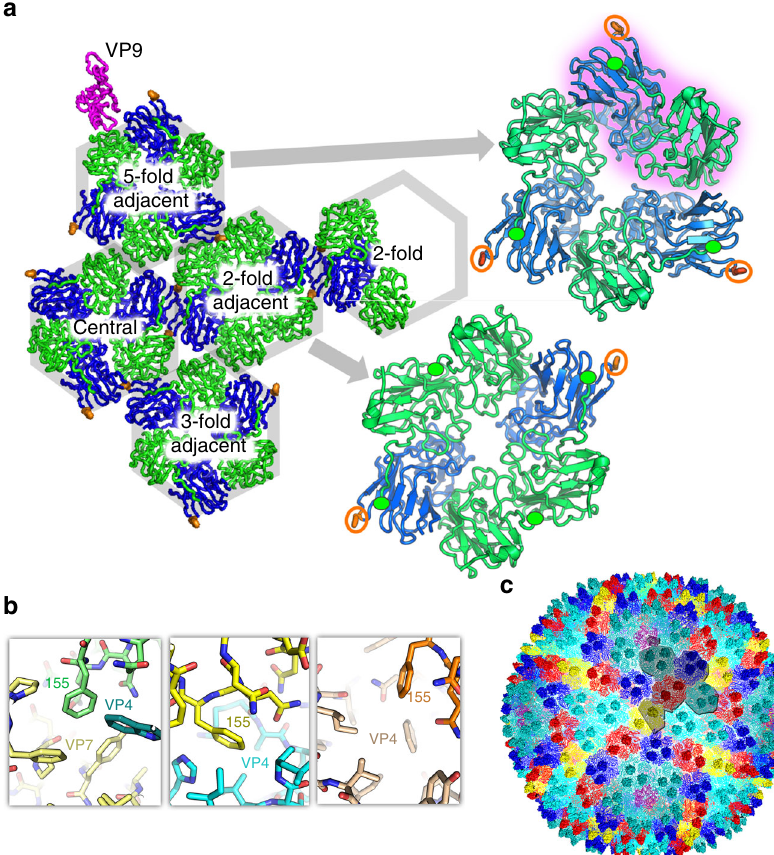
Fig. 2 Hetero-hexamer building blocks. a An icosahedral asymmetric unit, viewed from the inside. VP4 is blue, VP7 green and VP9 magenta. The hexamers are labelled and the arrows show close-ups of a type III turret (upper) with one VP7 − VP4 building block highlighted in purple. The N-termini of VP7 are marked by green ellipses and the side chain of Phe 155 of VP4 shown and circled in orange. b The three distinct environments of Phe 155 (shown in green, yellow and orange from left to right, with the neighbouring subunits coloured differently). c Capsid coloured according to hexamer type: cyan — 5-fold adjacent (type III); dark blue — central (type III); pale cyan — 3-fold adjacent (type III); red — 2-fold adjacent (type II); yellow — 2-fold adjacent (type III). VP9 is shown in magenta. One icosahedral asymmetric unit is